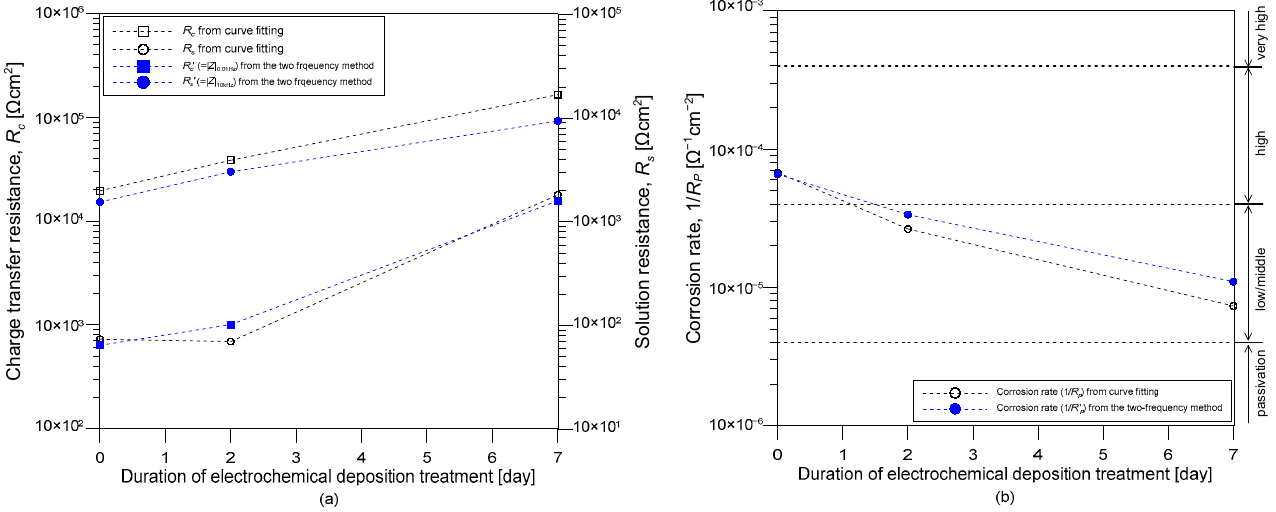
Figure 10. Variation of electrochemical impedance spectroscopy (EIS) parameters with duration of electrochemical deposition treatment (EDT): ( a ) variation of charge transfer resistance (on the left side in the y axis) and solution resistance (on the right side in the y axis) with duration of EDT, and ( b ) variation of corrosion rate with duration of EDT.